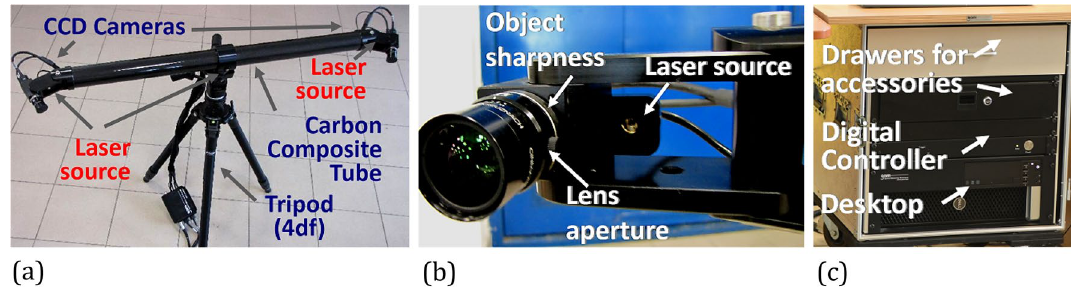
Figure 1. The PONTOS 5 M: ( a ) general view, ( b ) elements of the system located near the CCD camera, ( c ) control tower.